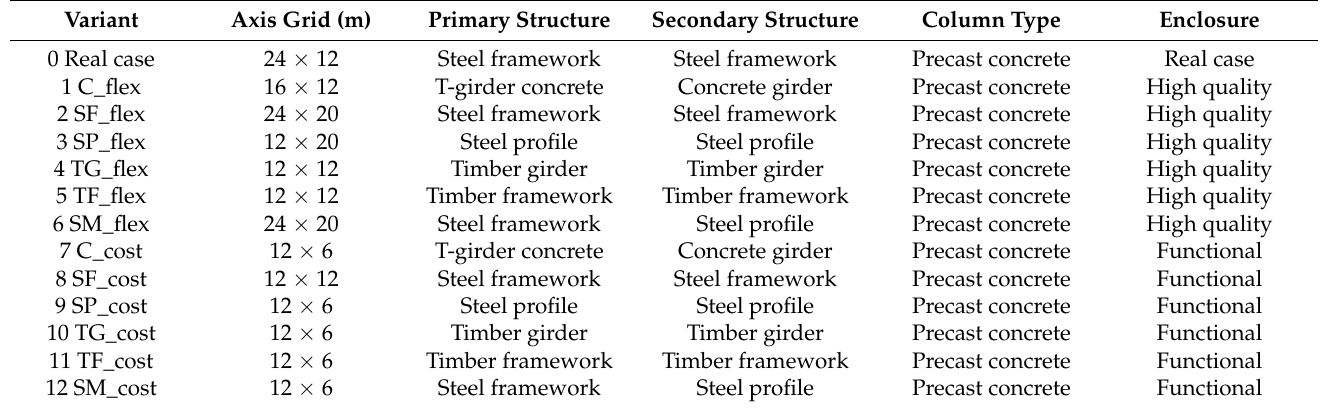
Table 1. Variant study design: examined structural types and envelope combinations.